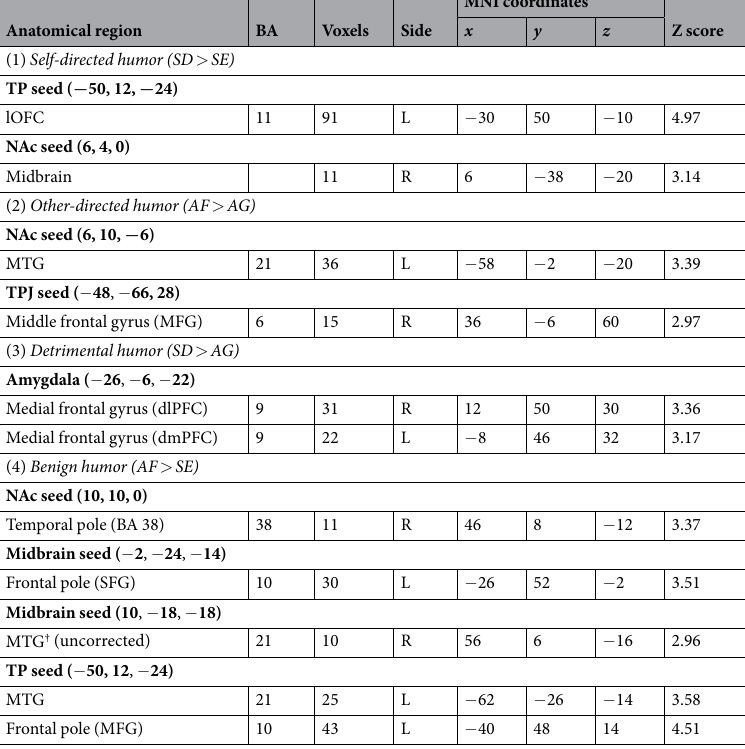
Table 3. Functional connectivity of the seeds of psychophysiological interaction (PPI) analyses. Note: The activation threshold was set at p < 0.05 and FWE (familywise error rate) corrected at the peak level, and clusters greater than or equal to 8 are